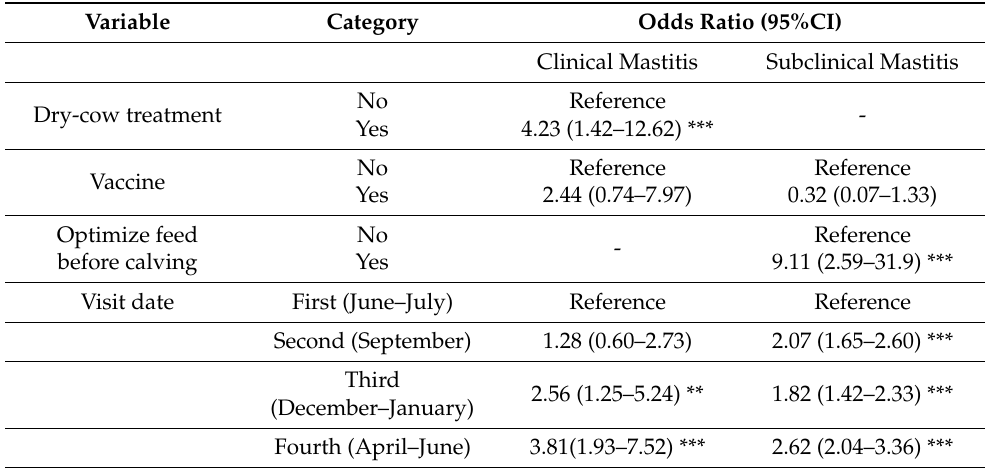
Table 4. Final multivariable logistic regression model of associations between herd level environmen- tal and management practices and clinical and subclinical mastitis at a quarter level in 10 smallholder dairy herds in Piracicaba Mesoregion, S ã o Paulo, Brazil.